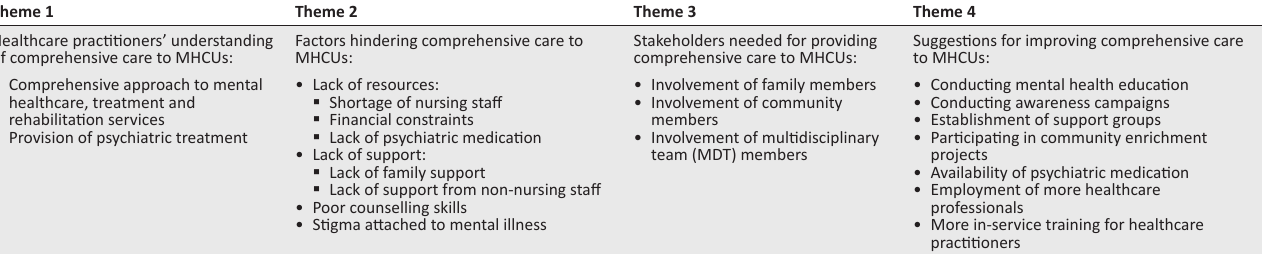
TABLE 1: Healthcare practitioners’ views regarding providing comprehensive care to mental healthcare users in a community